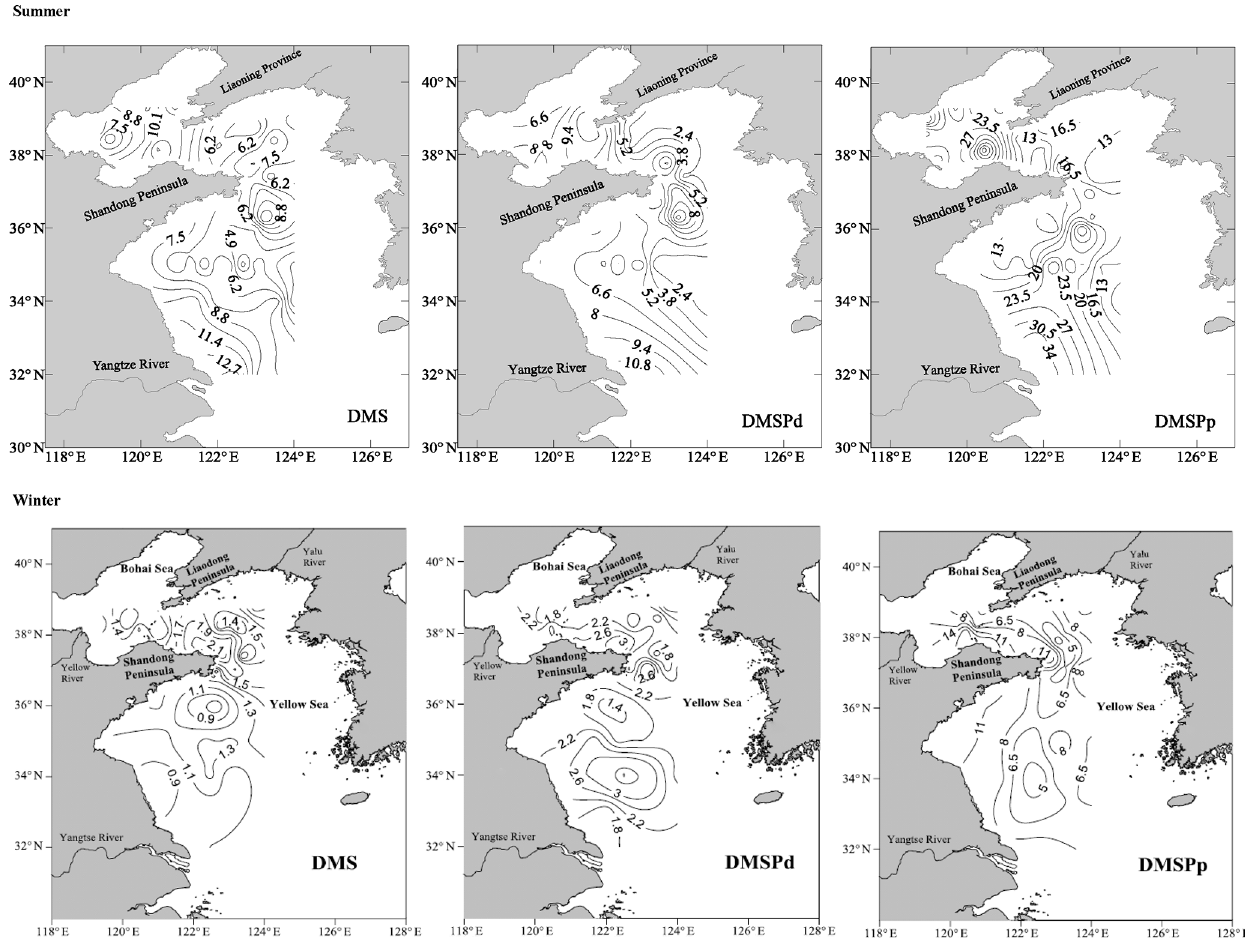
Figure 3. Horizontal distributions of DMS (nmolL − 1 ), DMSPd (nmolL − 1 ), and DMSPp (nmolL − 1 ) in the surface water of the BS and YS during summer and winter. Data in summer and winter presented here were described by Jin (2016) and Sun (2017),